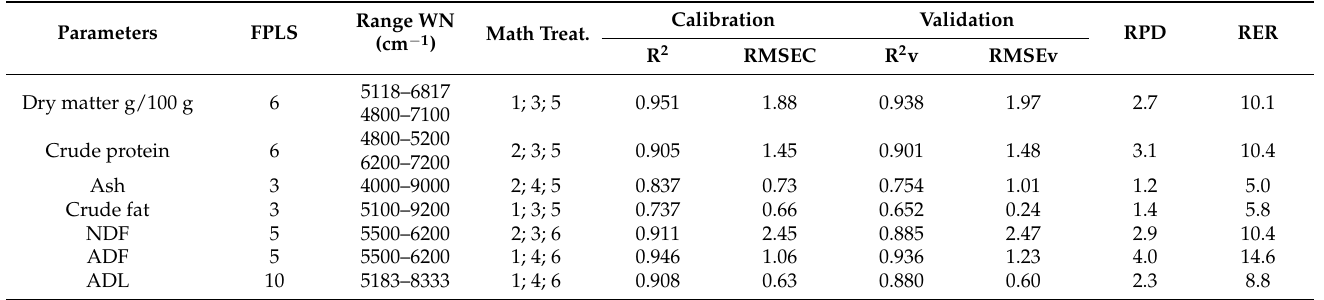
Table 2. Near-infrared spectroscopy (NIRS) predictive equations (calibration and external